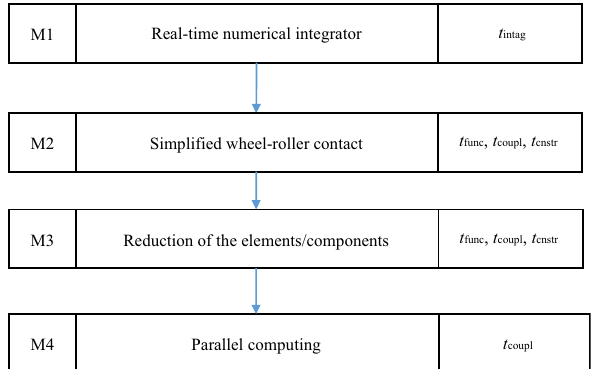
Real-time numerical integrator